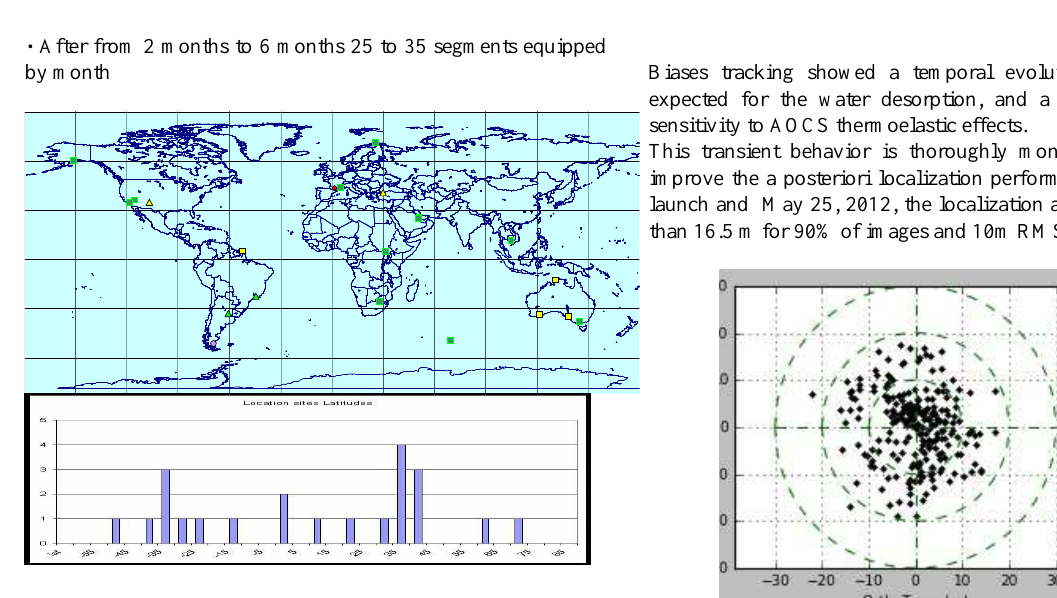
Figure 5 : Location sites position